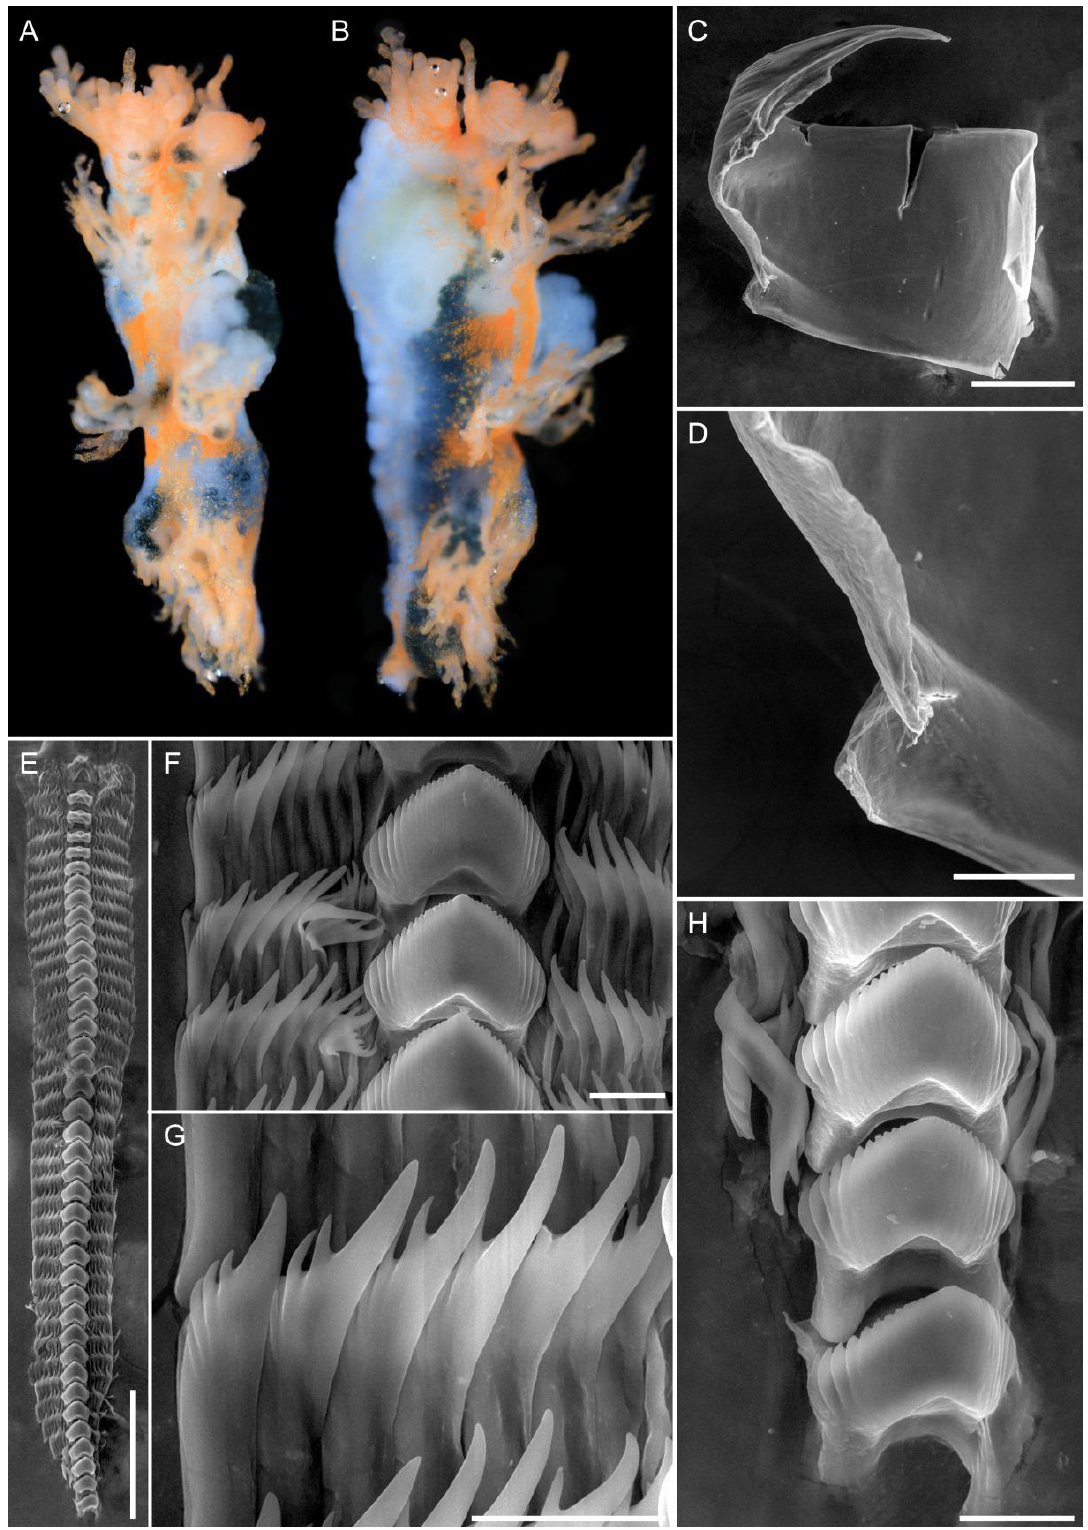
Figure 6. Dendronotus chishima sp. nov., features of external and internal morphology (SEM) of holotype MIMB44622. ( A , B ) — living holotype, dorsal view ( A ) and lateral view from the left ( B ). ( C ) — right jaw plate. ( D ) — masticatory process of the jaw. ( E ) — radula. ( F ) — posterior radular portion. ( G ) — lateral teeth. ( H ) — rachidian teeth, anterior radular portion. Scale bars: ( C , E ) = 300 µm; ( D ) = 100 µm; ( F – H ) = 30 µm.